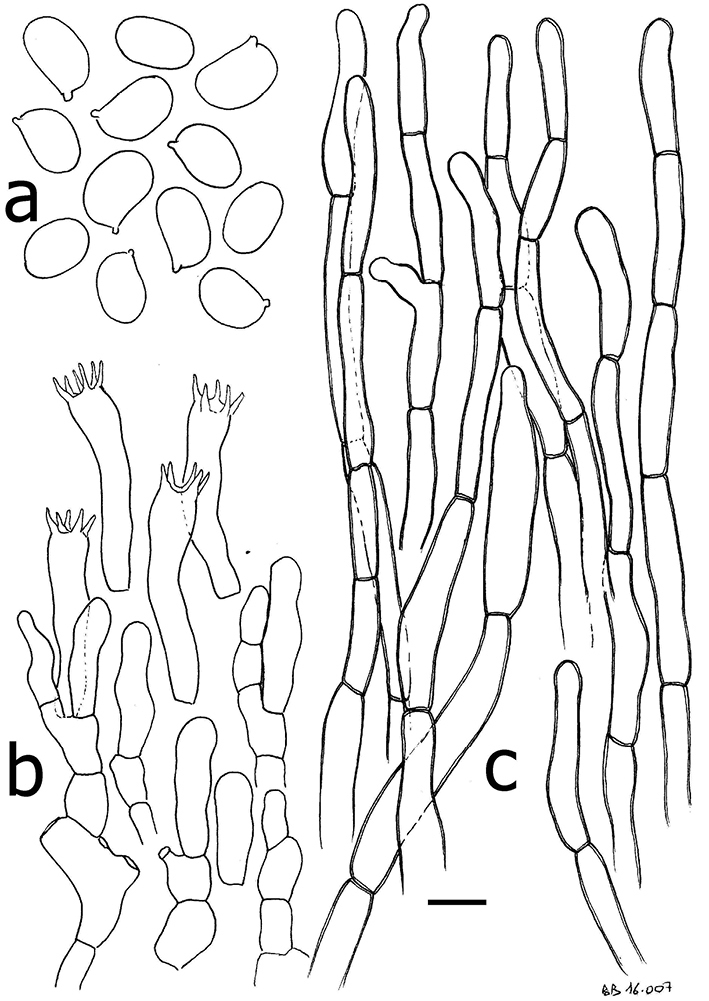
Cantharellustomentosoides. Microscopic features: a basidiospores b basidia and basidiola c densely septate and nearly thin-walled hyphal extremities of the pileipellis. Scale bar: 10 µm but only 5 µm for basidiospores. Drawings: B. Buyck.